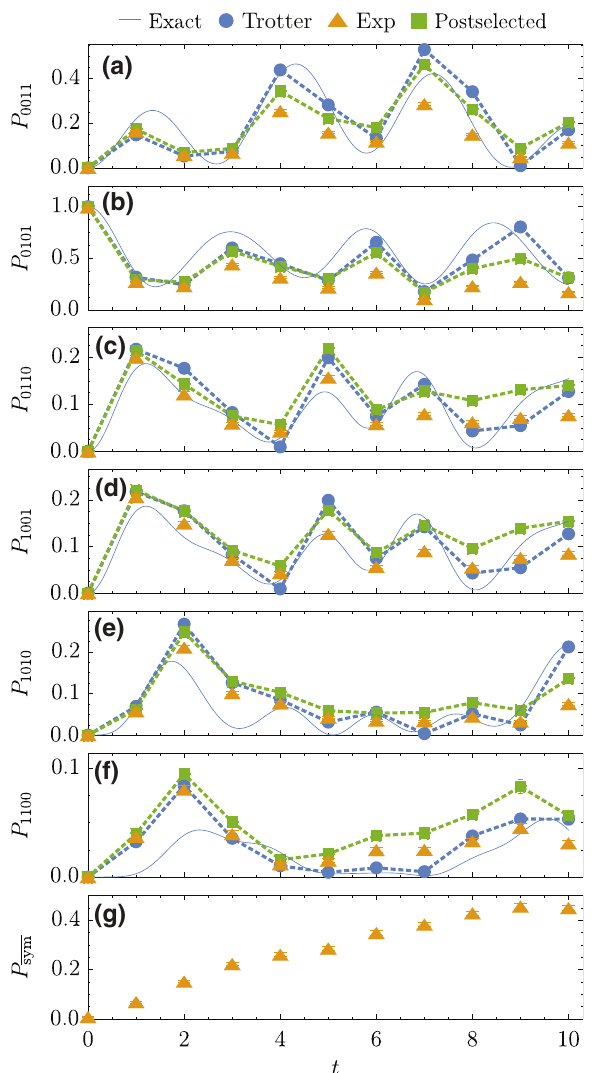
FIG. 11. The evolution of states characterized by the quantity P (cid:17) ≡ | (cid:6) (cid:17) | e − it ˆ H | ψ 0 (cid:2) | 2 in the (a)–(f) symmetry-allowed and (g) symmetry-forbidden subspace for N = 4 and δ t = 1.0, starting from the bare-vacuum state | ψ 0 (cid:2) . Note that P 0101 ≡ P vac , which is also plotted in Fig. 7 of the main text. The effectiveness of post- selection in mitigating errors is both quantity and time dependent and, in some cases, it ceases to improve the agreement with theory at larger